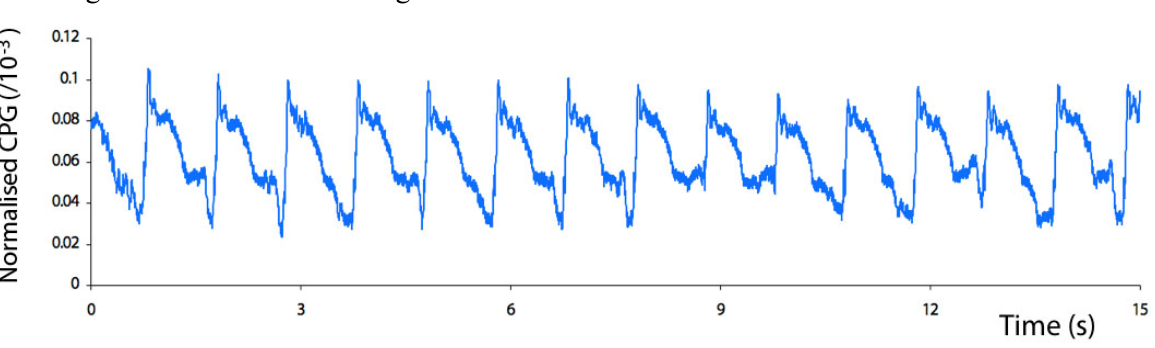
Figure 4. Sample of the time-varying capacitance plethysmograph (CPG) signal obtained when the systolic pressure was 250 mmHg and the dye concentration was equivalent to a hemoglobin concentration of 5